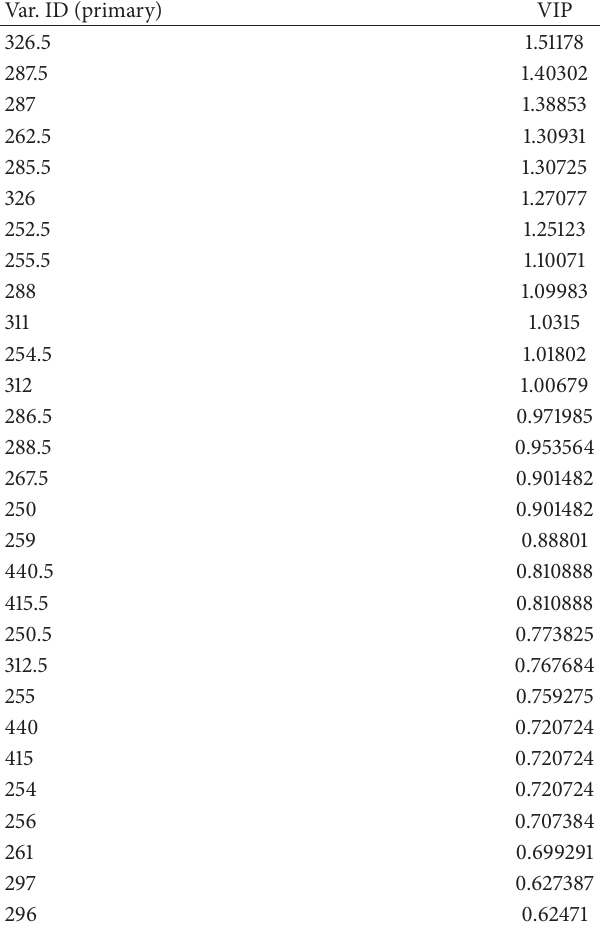
Table 2: VIP scores of PLS-DA. Var. ID